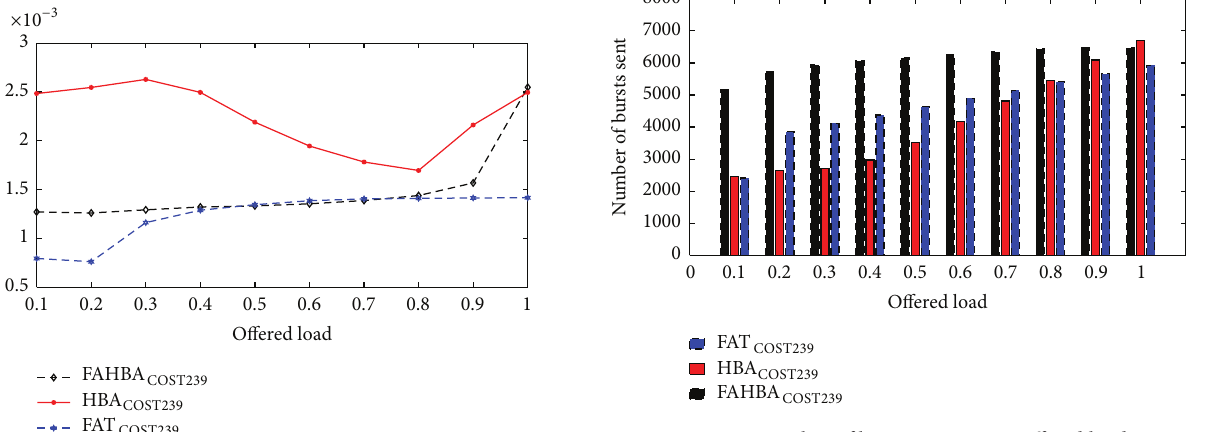
Figure 7: Number of bursts sent versus offered